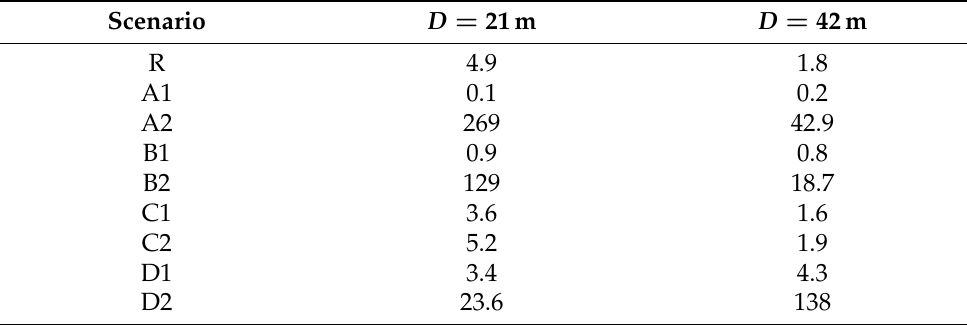
Table 5. Solving CPU times (in